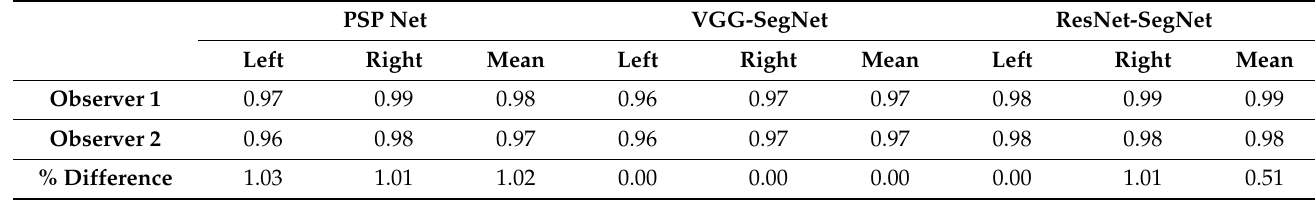
Left Right Mean Table 2. Comparison of the CC values obtained between AI model lung long axis and the GT lung long axis corresponding to Observer 1 and Observer 2.